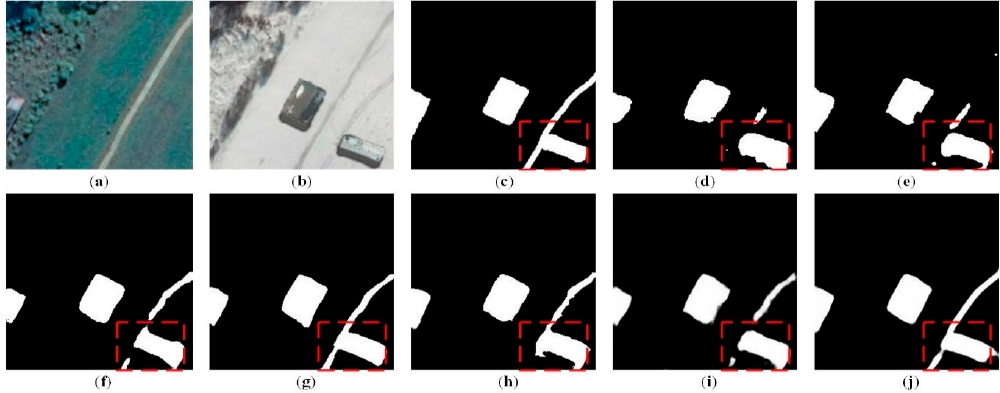
Figure 7. Visual comparisons of change detection results using di ff erent approaches for area 1: ( a ) image T 1 , ( b ) image T 2 , ( c ) reference change map, ( d ) CDNet, ( e ) FC-EF, ( f ) FC-Siam-conc, ( g ) FC-Siam-di ff , ( h ) FC-EF-Res, ( i ) FCN-PP, and ( j ) proposed method. The changed parts are marked in white while the unchanged parts are in black.